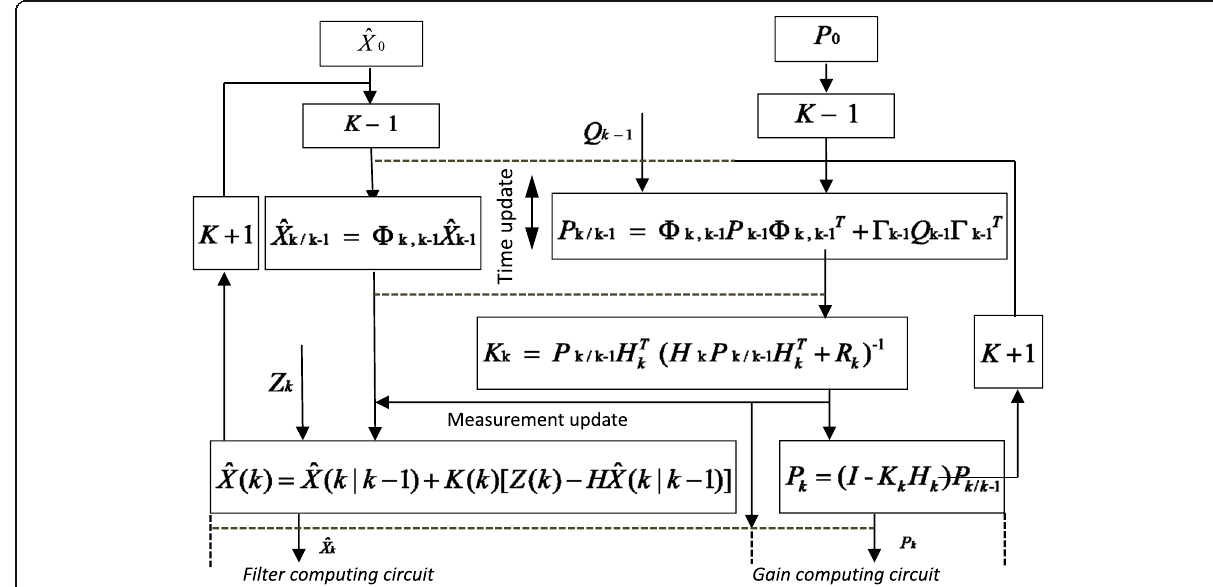
Fig. 1 The chart of Kalman filtering algorithm. Given the initial value, the state estimation at k time can be obtained by recursive calculation according to the observed value Z ( k ) at K time